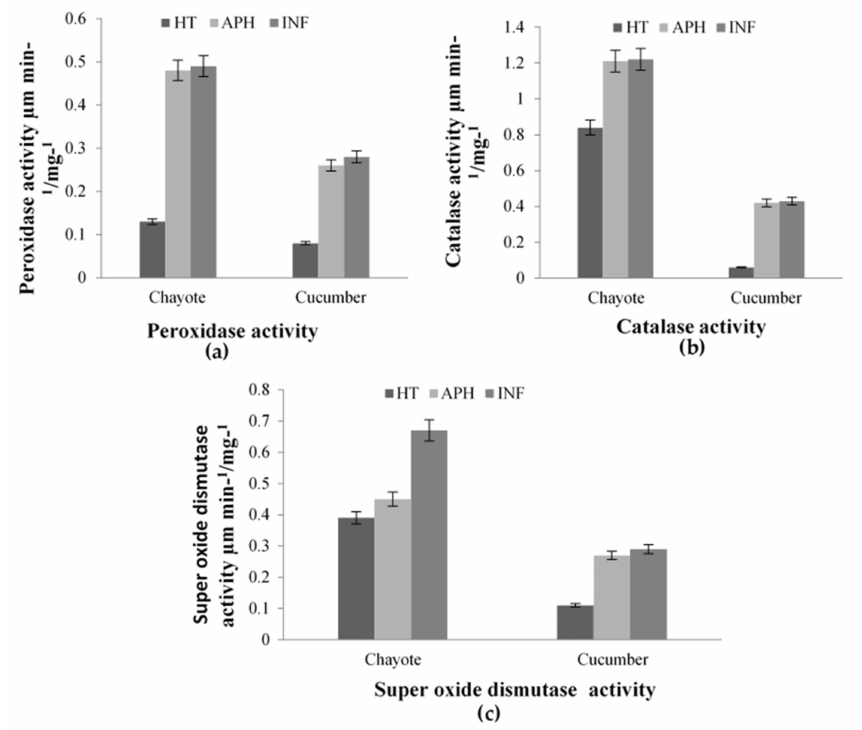
Figure 6. ( a ) Peroxidase (POX), ( b ) catalase (CAT), and ( c ) superoxide dismutase (SOD) antioxidant enzyme activity of melon fly infection in healthy (HT), apparently healthy (APH), and infected (INF) tissues of cucurbit and chayote fruit. The vertical bars indicate the standard error p = 0.05. Increased POD activity was noticed in chayote infected tissue than apparent healthy and healthy tissues. There was a moderate rise in the activity of cucumber infected tissue as that of healthy tissue. Similarly, infected chayote tissue exhibited excellent CAT activity compared to its healthy counterpart and cucumber tissues (Figure 6). The rise in activity of both POX and CAT was low in cucumber infected tissue compared to infected chayote tissue. The SOD showed an increased activity of 39.16% in infected chayote tissue compared to apparently healthy and healthy tissues (Figure